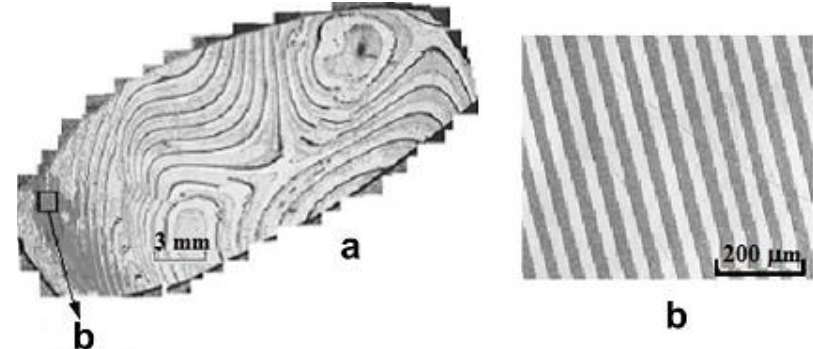
Figure 8. Growth domain structure of LiNbO 3 :Gd (0.26 wt.%) crystal in a plane perpendicular to the growth axis. ( a ) Panorama; ( b ) growth domain structure at the periphery of the plate.